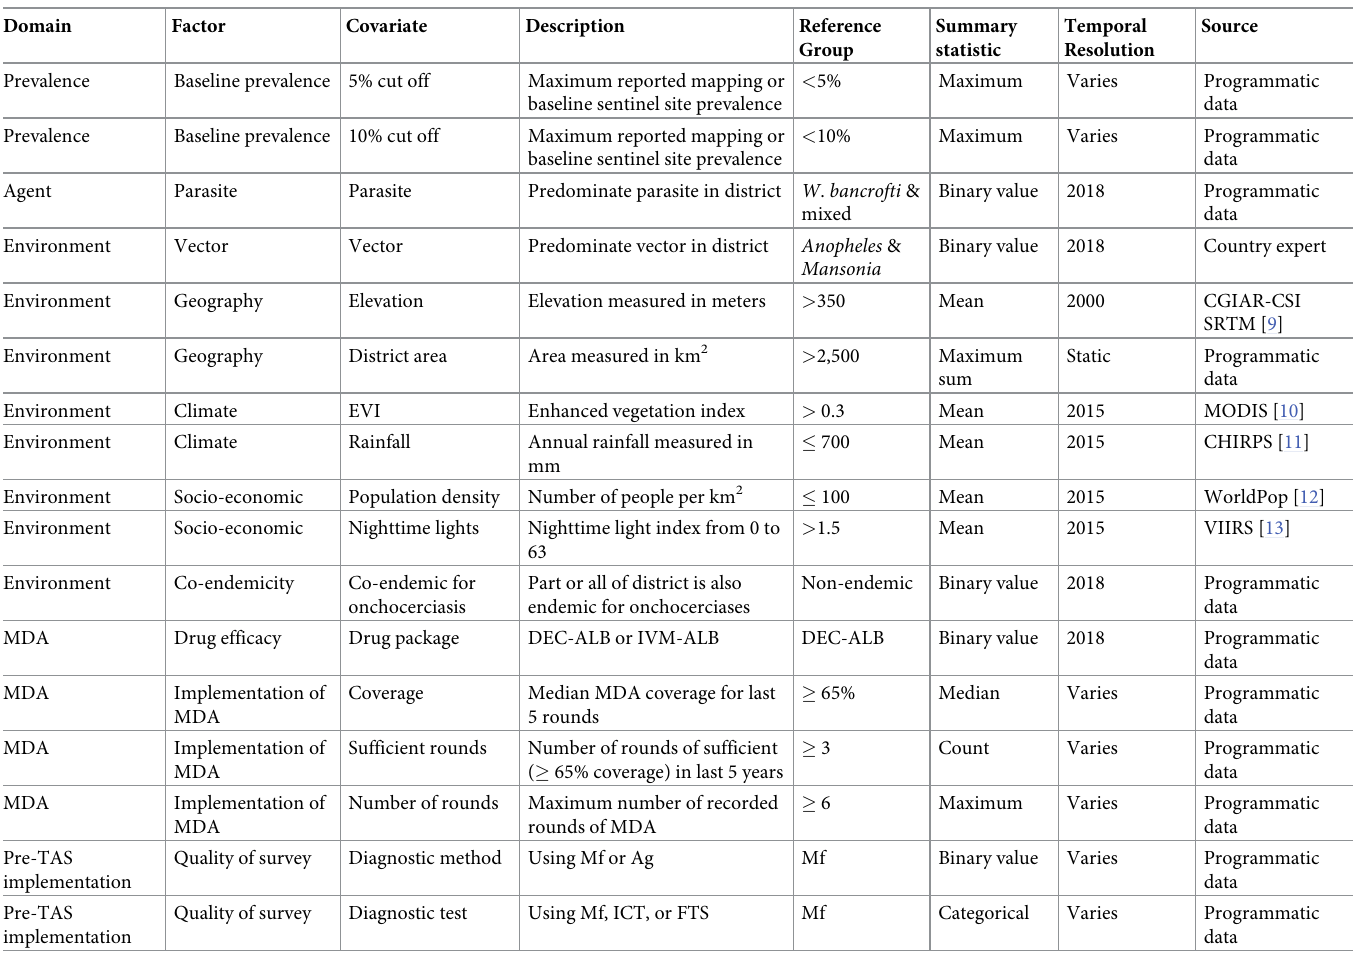
Table 1. Categorization of potential factors influencing pre-TAS